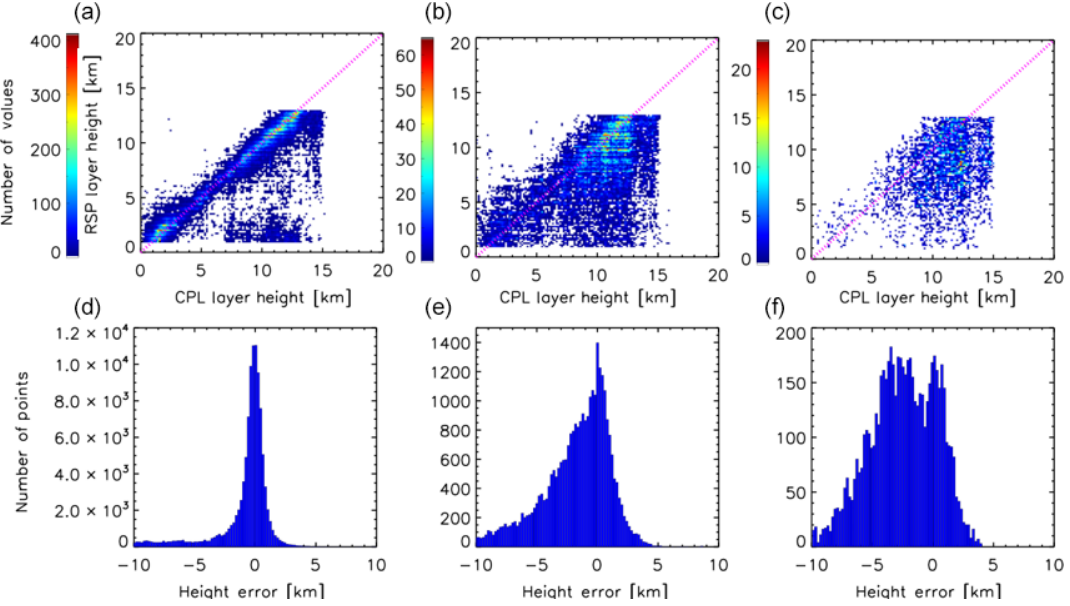
Figure 12. Same as Fig. 11 but for the 670nm band